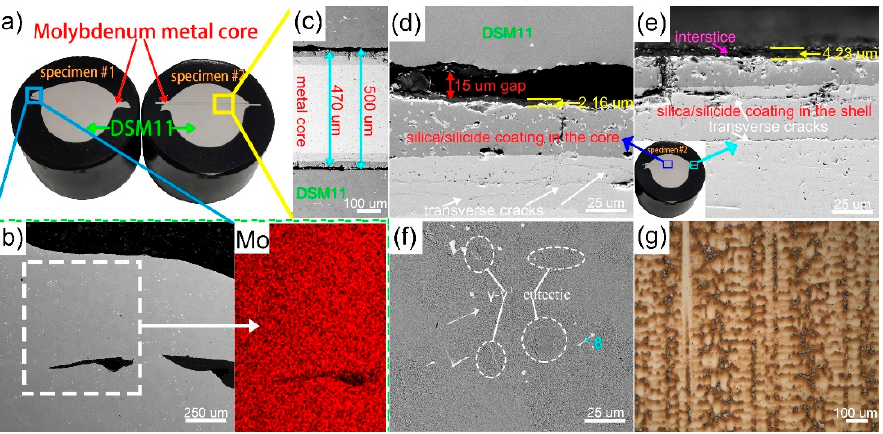
Figure 4. ( a ) The macro appearance of as-cast specimens;( b ) The BSE image of as-cast specimen #1, corresponding Mo mapping of Figure 4 ( b ); ( c ) The low-magnification BSE image of as-cast specimen #2; ( d ) The high-magnification BSE image of as-cast specimen #2; ( e ) The BSE image of the metal core near in the shell; ( f ) The BSE image of DSM11 ingot; ( g ) The micrograph of the longitudinal cross sections of the DSM11 ingot.